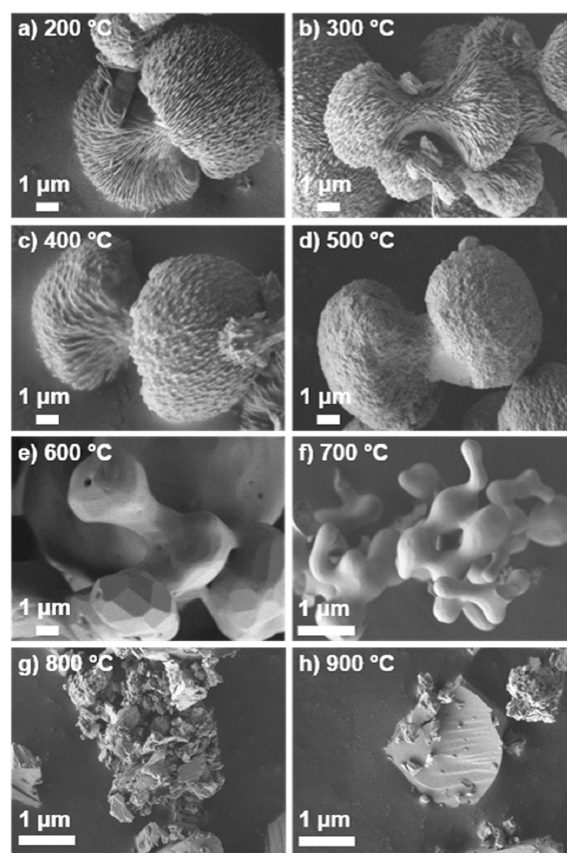
Figure 7. SEM images ( a – h ) of LCP- Cmcm (PO) after annealing in the temperature range from 200 to 900 °C (increment: 100 °C). The samples ( f – h ) are shown with higher resolution for clarity.